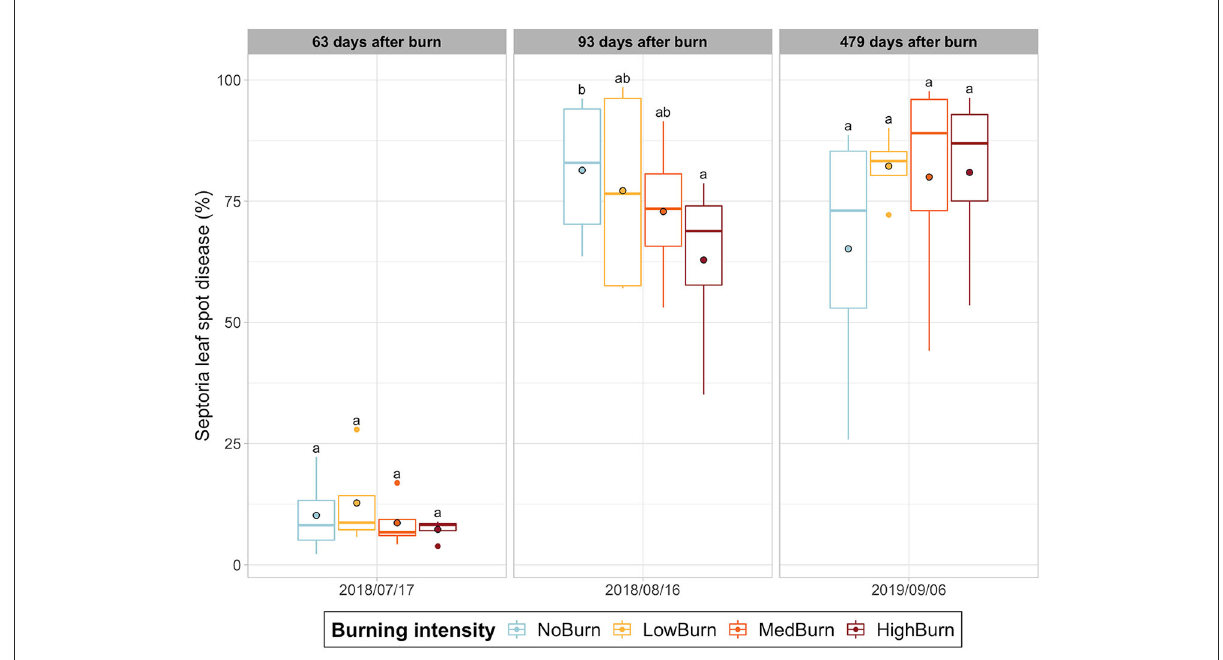
FIGURE3 Septoria leaf spot disease incidence over time. Mean value is indicated with a black-circled dot. Significant difference in each sampling date is indicated by letters according to post hoc Tukey tests.